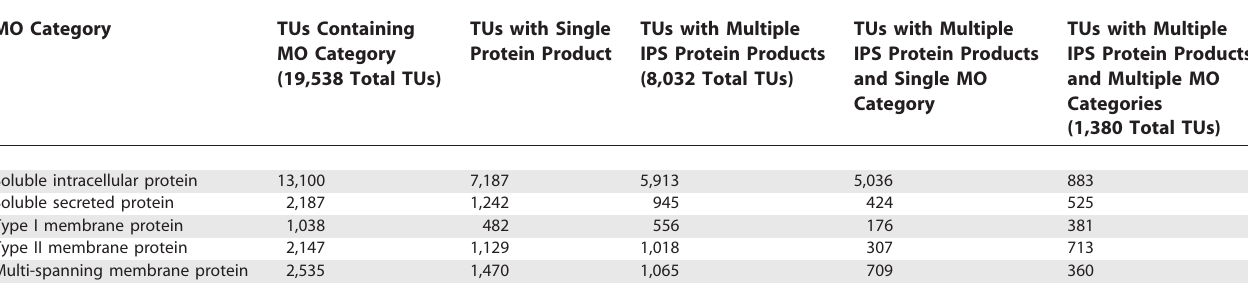
Table 3. Analysis of Membrane Organization Variation at the Level of TUs for 33,451 Protein Sequences Belonging to 19,538 TUs MO Category TUs Containing MO